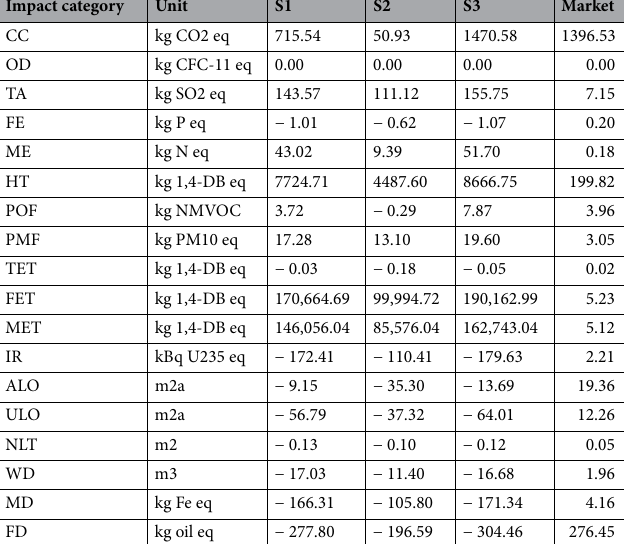
Table 2. The characterization results between these three systems and